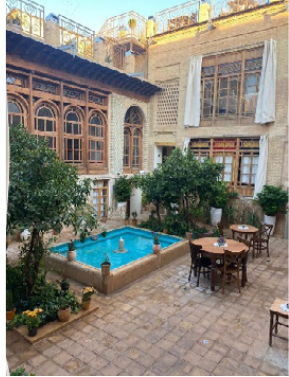
Fig 2: Central courtyard and howz—small blue pool